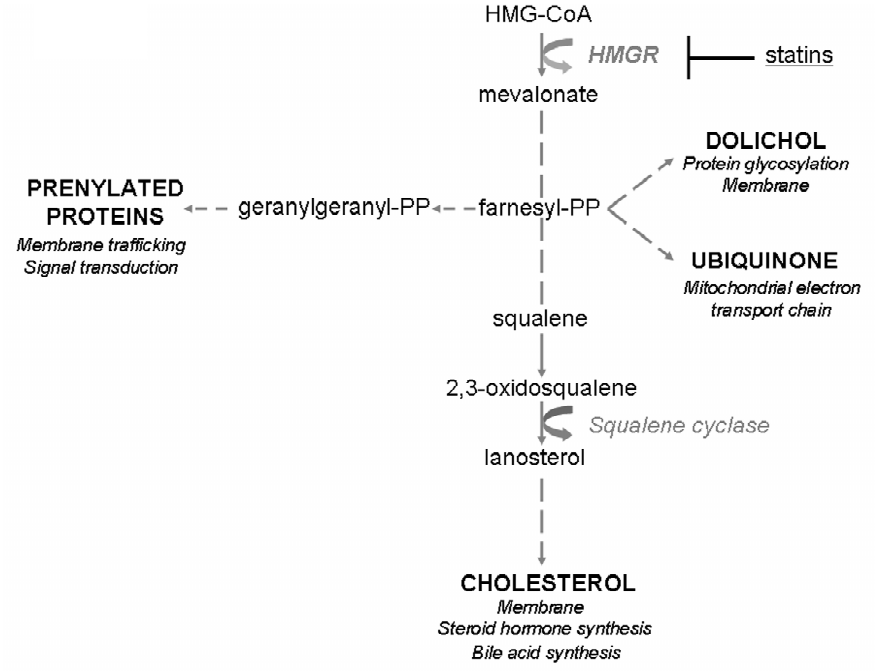
FIGURE 1. Schematic illustration of the biosynthetic pathway of HMGR end